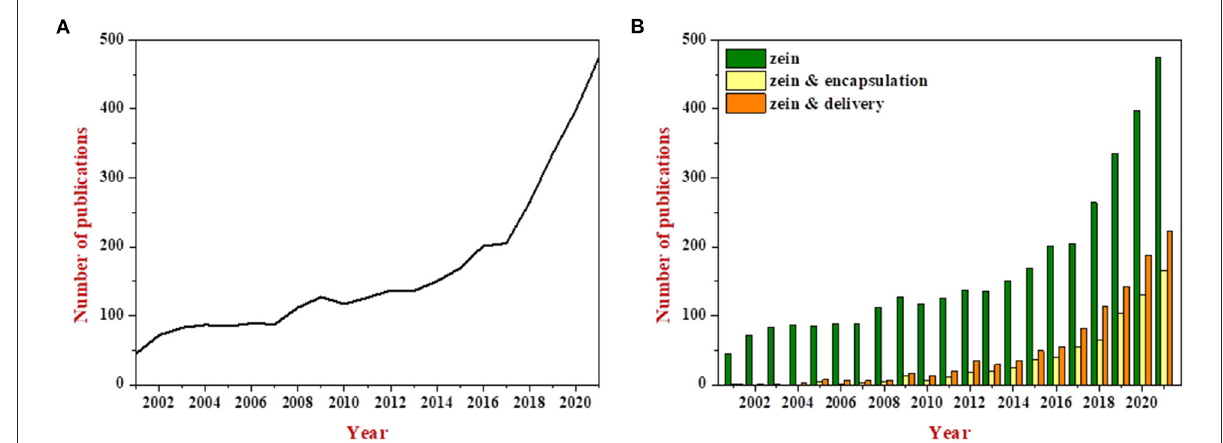
FIGURE1 Evolution of number of publications related to the term “zein” during the years 2001 to 2021 (A) ; Comparison of the number of publications related to the terms “zein” vs. “zein & encapsulation” and “zein & delivery” (B) . All the data were obtained through the Web of Science system.